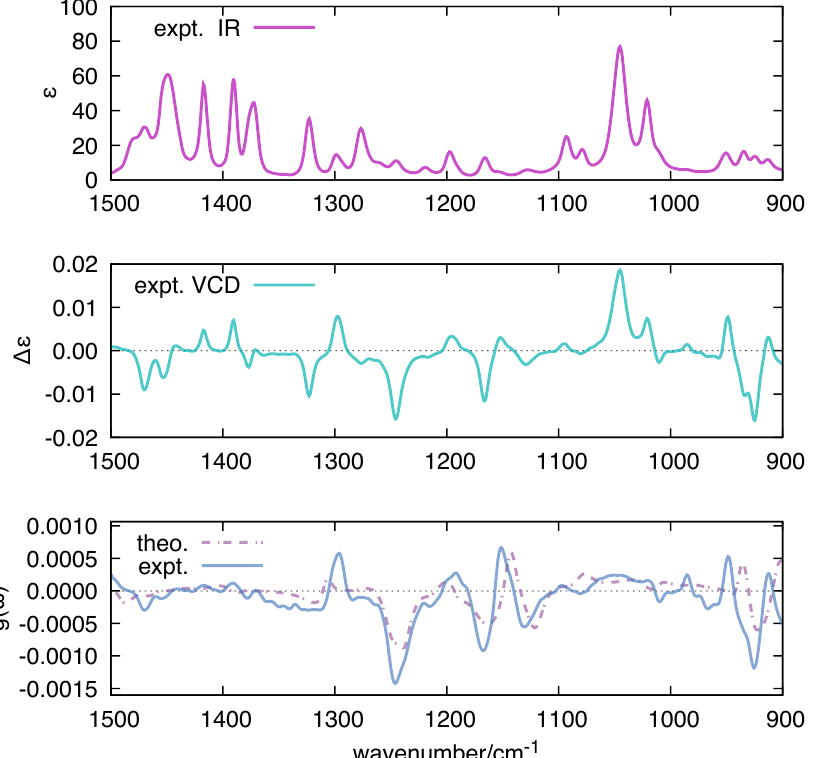
Figure 8. Comparison between the experimental g -ratio of 1 S -CAM and the g -ratio calculated by polar based on Equation (12) ( Γ = 10 cm − 1 ). DFT calculations on 1 S -CAM have been carried out at B3LYP/aug-cc-pVTZ level; for ease of comparison with experimental data, the wavenumbers computed by DFT were scaled by 0.98.